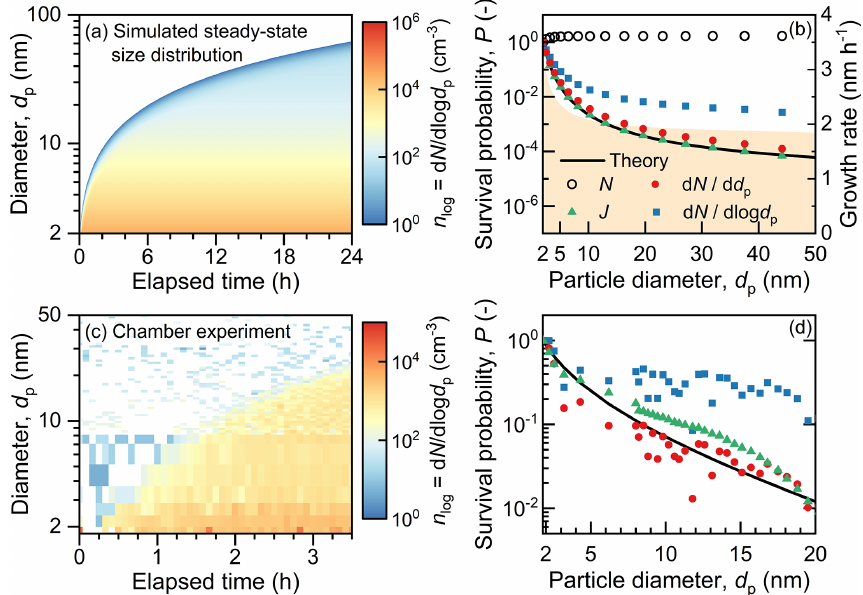
Figure 3. Survival probabilities of new particles with steady-state size distributions. (a) Simulated size distribution of new particles. The formation rate and size-dependent growth rate of particles are maintained time-independent during the simulation. (b) The survival probability of new particles in the simulated new-particle-formation event retrieved using different methods. N is herein the total number concentration of particles. (c) An NPF event measured in the CLOUD chamber. (d) The survival probability of new particles in the measured NPF event evaluated at 3.5h elapsed time.